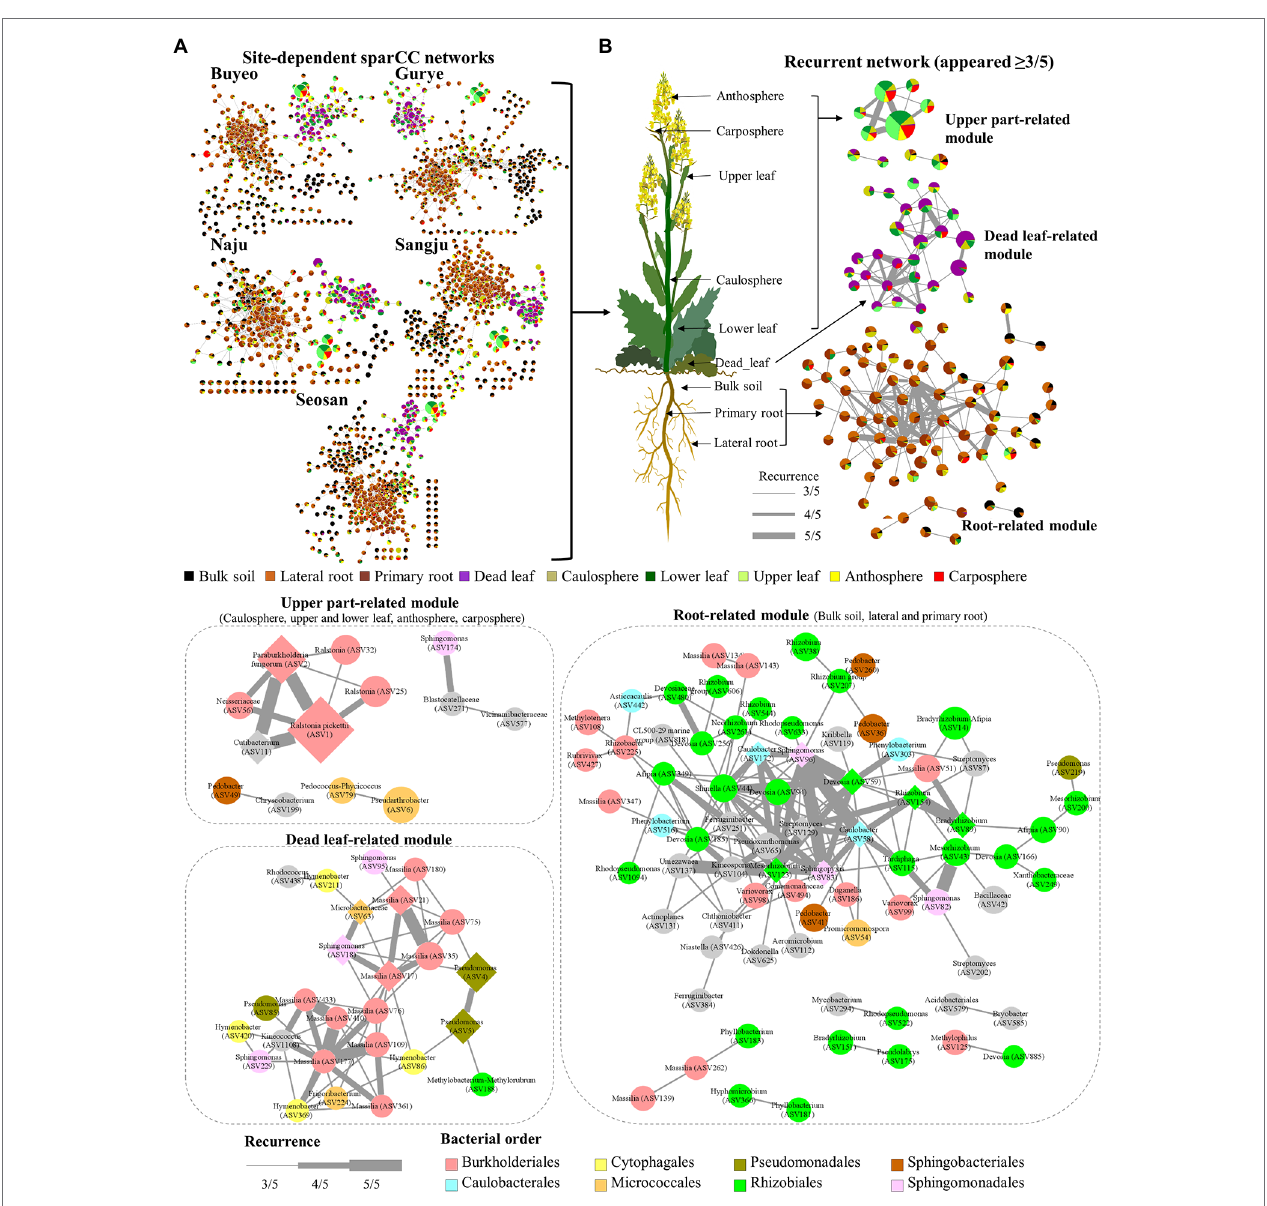
FIGURE 4 | Structure of site-dependent networks and recurrent network. (A) Site-dependent networks. The node colors represent the composition of holobiont components in each ASV. The node size represents the average total relative abundance. (B) Recurrent network. The thickness of edges represents the recurrence. Diamond nodes represent core